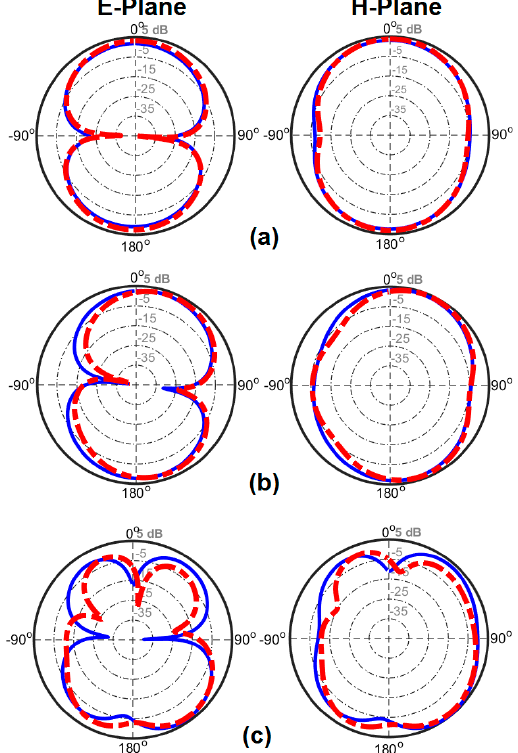
Figure 14. Measured (dash line ) and simulated (solid line) results of the antenna patterns at ( a ) 3 GHz, (b ) 6 GHz, and (c) 9 GHz.